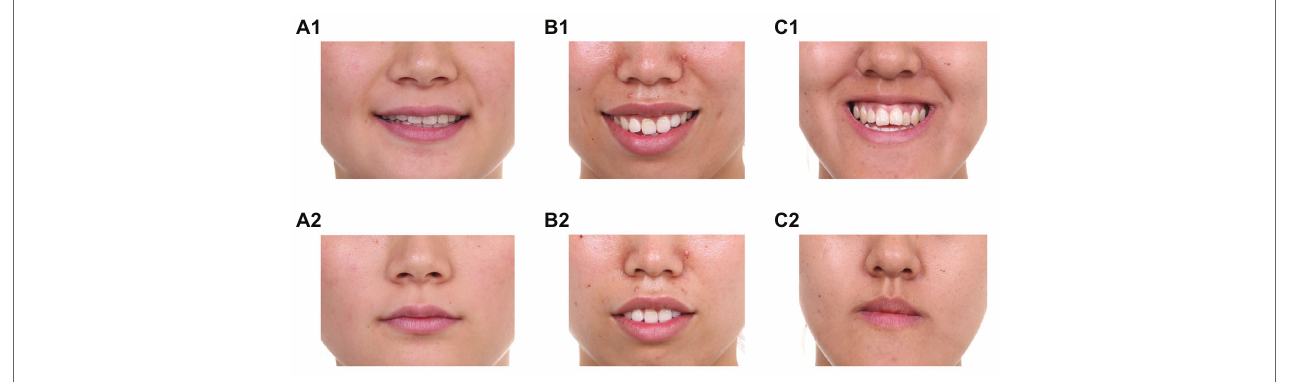
FIGURE 1 | Examples of various occlusions. (A1) Normal occlusion with a posed smile; (A2) Normal occlusion with a neutral expression; (B1) Maxillary protrusion with a posed smile; (B2) Maxillary protrusion with a neutral expression; (C1) Mandibular protrusion with a posed smile; and (C2) Mandibular protrusion with a neutral